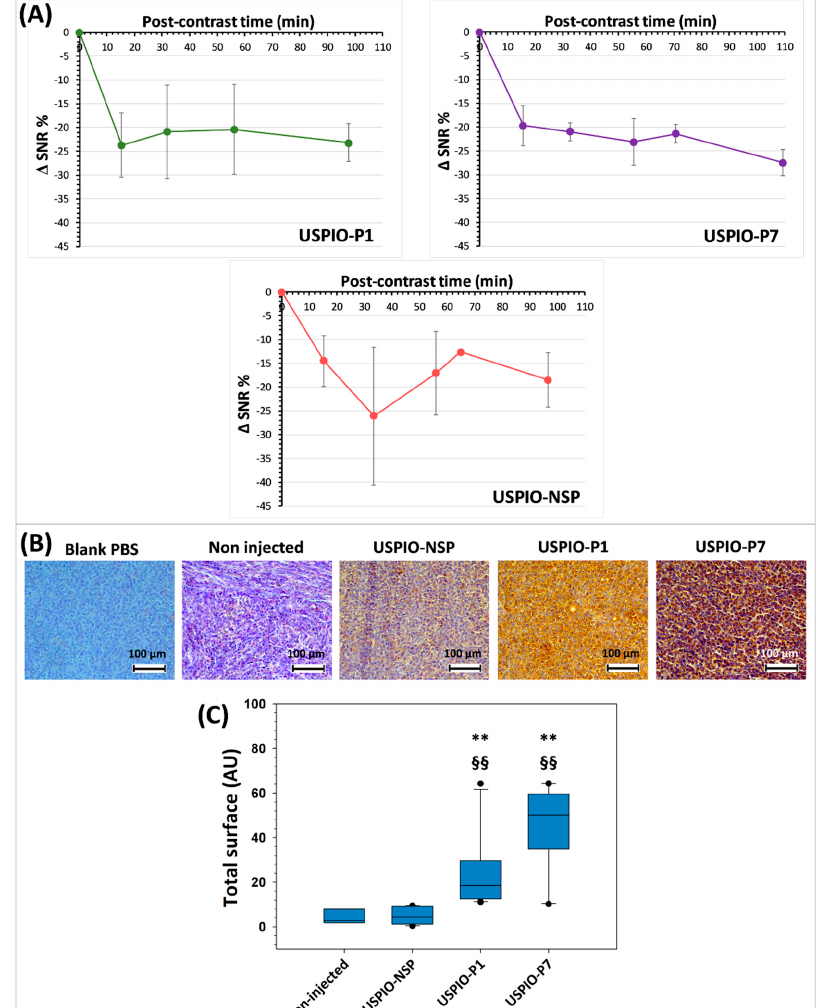
Figure 7. Time evolution of negative contrast ( Δ SNR%; signal-to-noise ratio) produced by USPIO derivatives at the level of TPC-1 tumors ( A ). Evidence of the presence of injected USPIO derivatives by anti-polyethylene glycol (PEG) antibody immunostaining in TPC-1 tumors grafted into athymic nude mice (all sacrificed after 130 min post-injection) ( B ). Analysis of the staining of iron nanoparticles by the anti-PEG antibody on TPC-1 tumors ( C ). The results shown in the box and whisker plots are statistically analyzed using the Mann–Whitney test: ** = p < 0.01 vs. USPIO-NSP; §§ = p < 0.01 vs. non- injected mice.